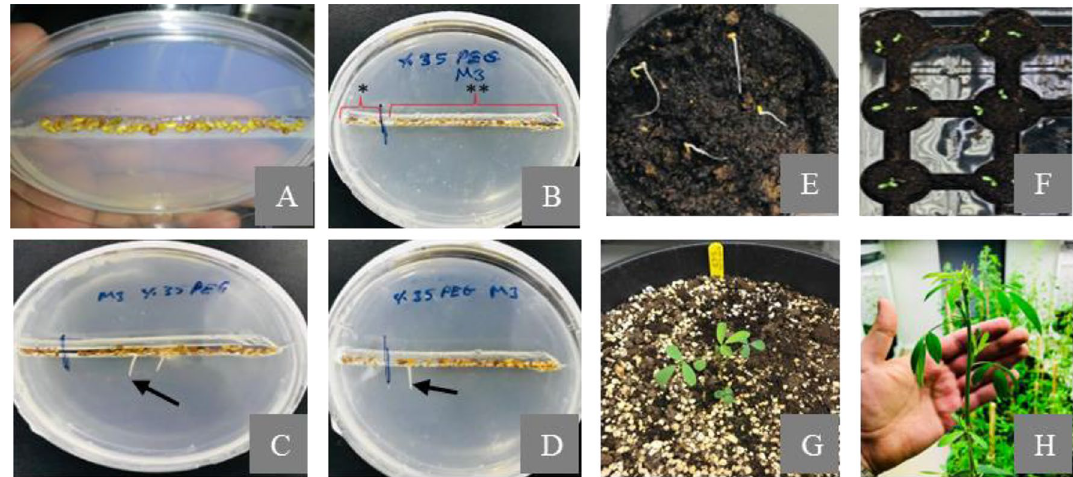
Figure 1. Screening mutant M 3 seeds and developed seedlings. ( A ) Close view of planted seeds on the raw of MS media containing 35% PEG 6000 . ( B ) *, unmutated control seeds; **, mutant M 3 seeds. ( C – D ) Candidate mutant seedlings from screening. Arrows show radicle elongations. ( E – F ) Rescued seedlings from MS media and planted into viols. ( G – H ) Seedlings planted into plastic pot and plant developed at flowering bud